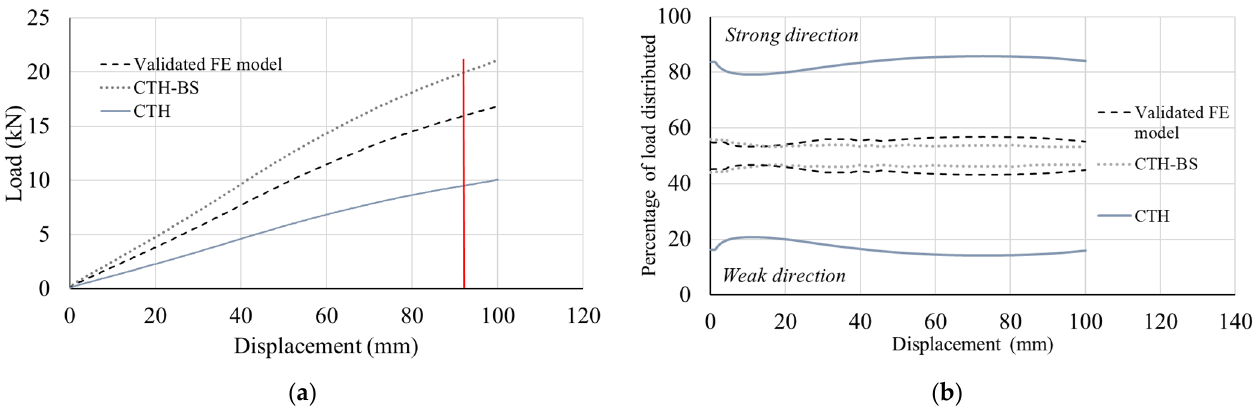
Figure 14. ( a ) Load-displacement curve comparison for decks of connected bottom flanges of top-hat ribs in the absence of corrugated base sheet, ( b ) Percentage load distributed along each direction of the deck through the entire loading stage.